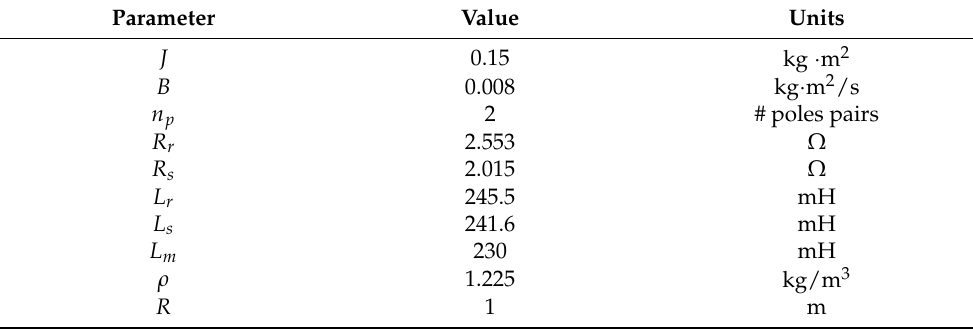
Table 1. System parameters for simulation platform of SCIG WECS. Parameter Value